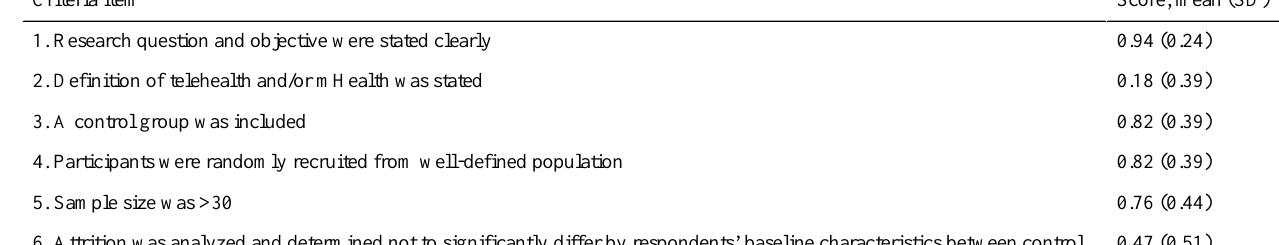
Score, mean (SD)Criteria